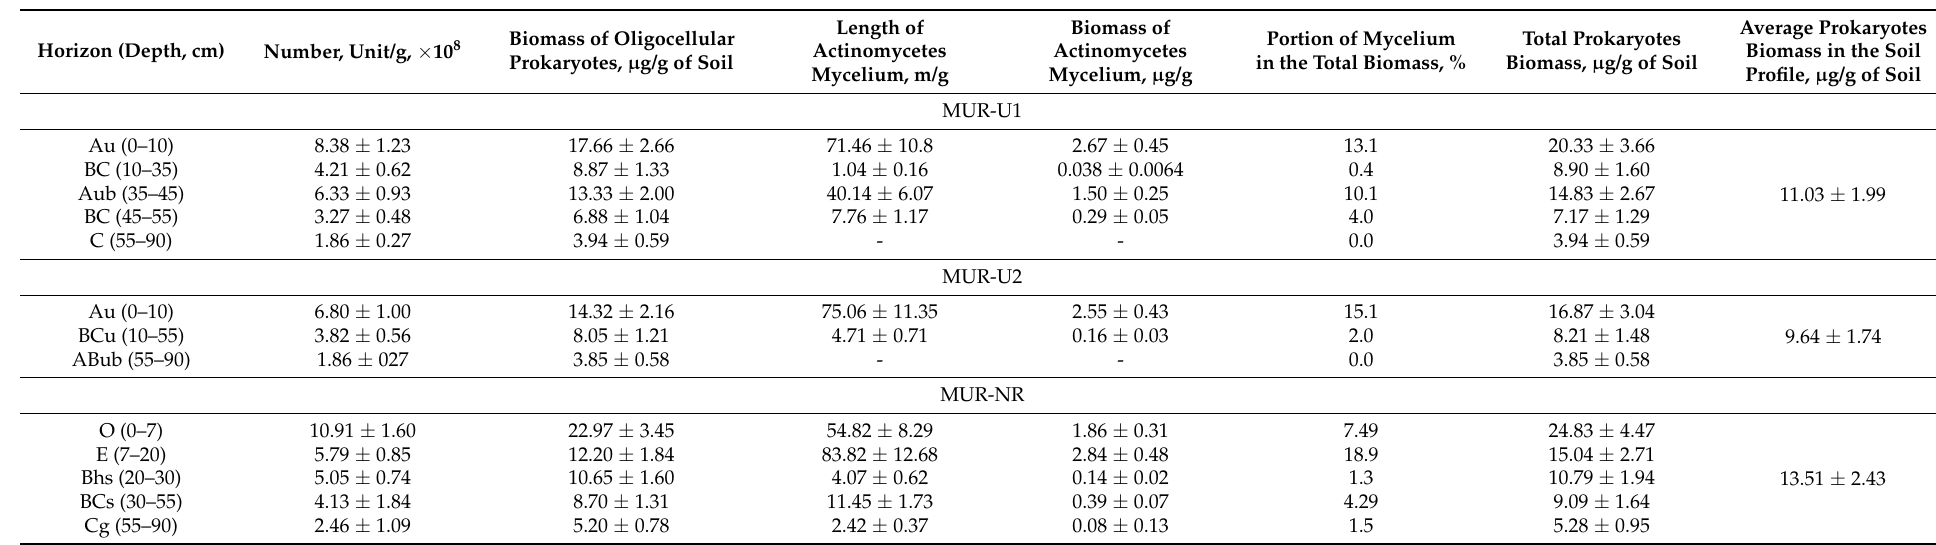
Table 4. Prokaryote’s